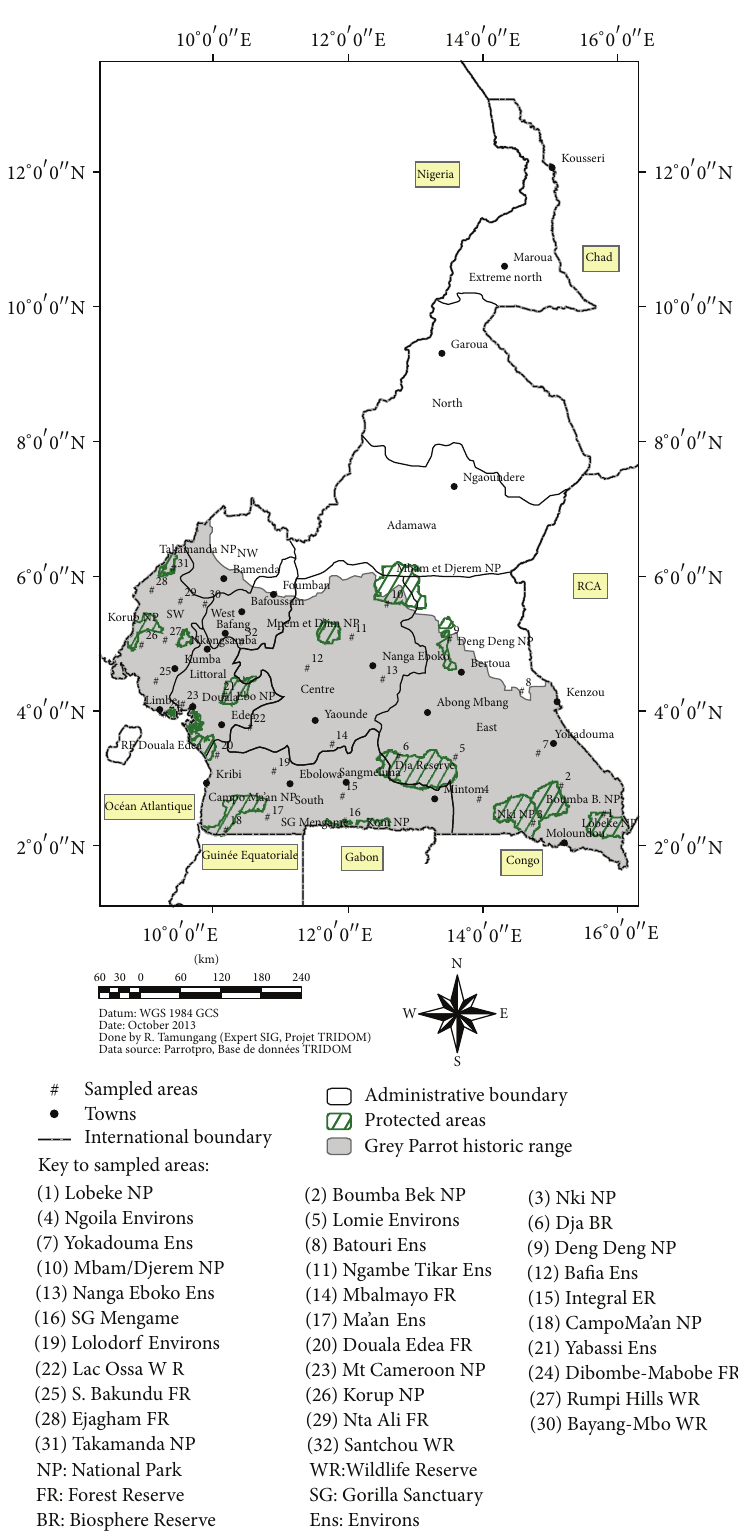
Figure 1: Historic range of the Grey Parrot in Cameroon, in relation to sampled areas, protected areas, urban centres, and administrative